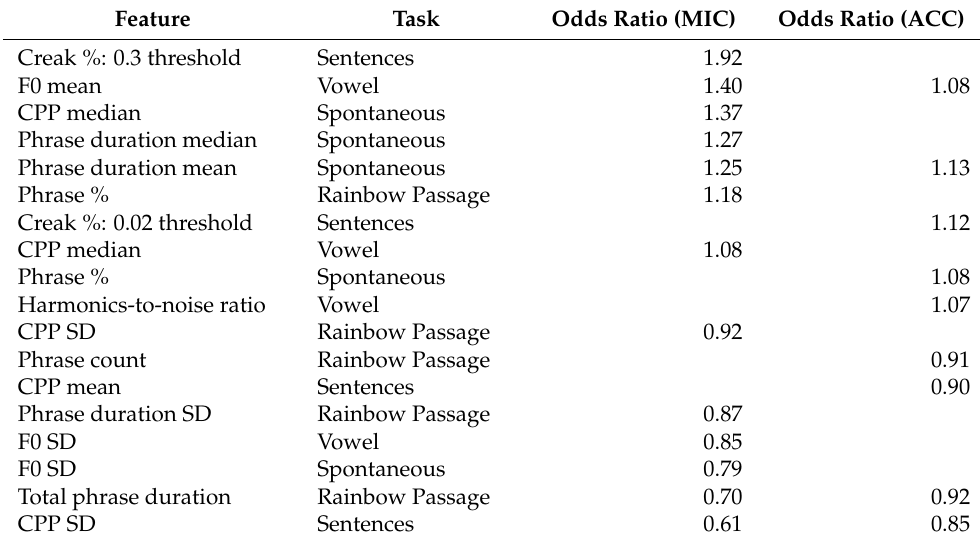
Table 2. Odds ratios for the MPT − models derived separately for the microphone (MIC) and neck- surface accelerometer (ACC) sensors.